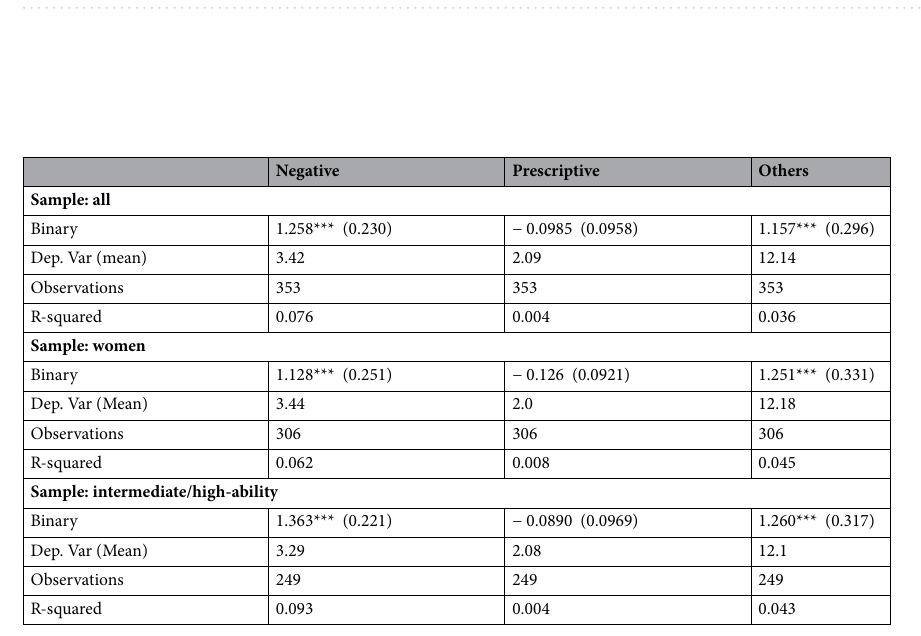
Figure 4. Binary vs. continuous settings: probability of agreement. Item by item. Lines with caps represent 95% CI.